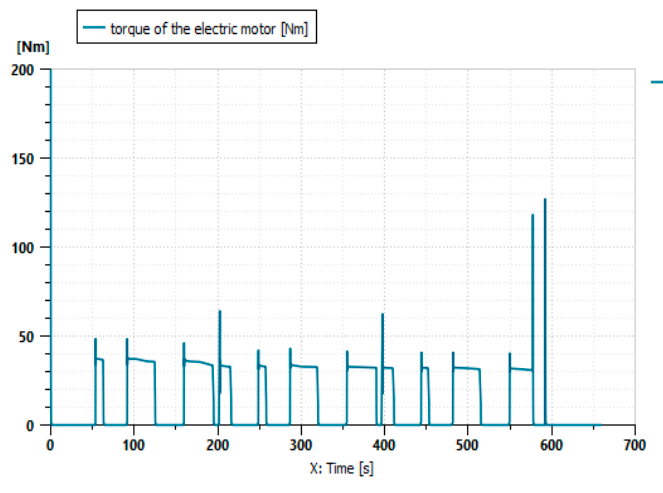
Figure 25. Electric motor torque.